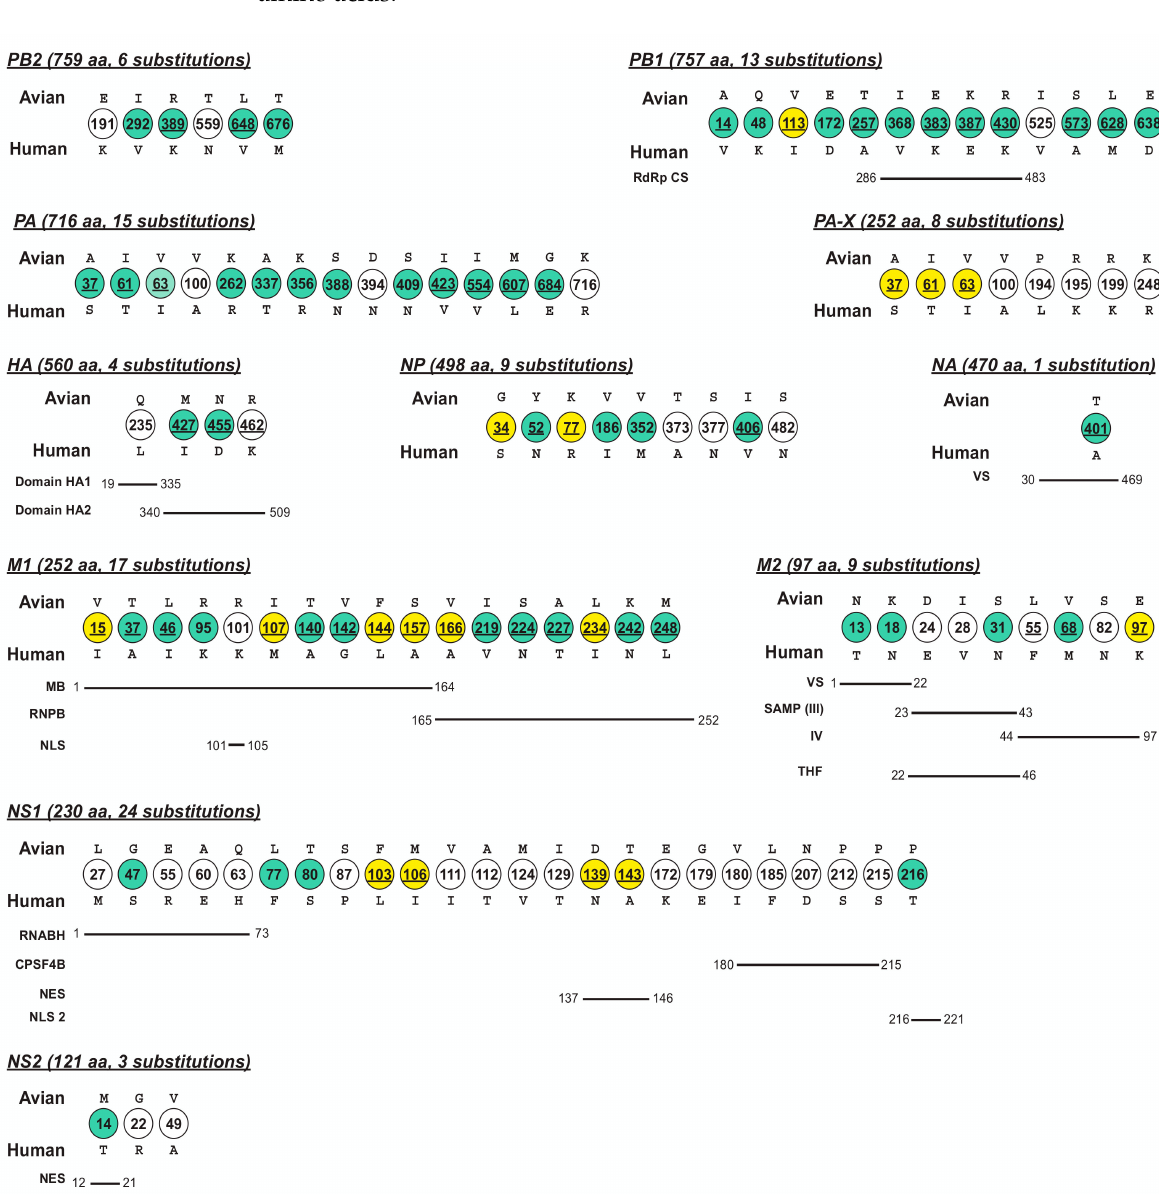
Figure 2. Avian-to-human (A2H) substitution identified in the proteins of influenza A (H7N9) viruses. The amino acid positions of the A2H substitutions are indicated in the circles, and those underlined are the 50 that remained unchanged in the recorded human H7N9 population. The circles in green shade are substitutions that occurred in the evolutionary path of A (H7N9) viruses [16]; while those in yellow were first detected in 2013. The protein numeration is based on protein sequence alignment. Abbreviations: RdRp CS, RdRp catalytic subunit; HA, hemagglutinin; VS, virion surface; MB, membrane binding; RNPB, ribonucleoprotein binding; NLS, nuclear localization signal; SAMP (III), signal-anchor for type III membrane protein; IV, intravirion; THF, transmembrane helical fragments; RNABH, RNA-binding and homodimerization; CPSF4B, cleavage and polyadenylation specificity factor 4 binding; and NES, nuclear export